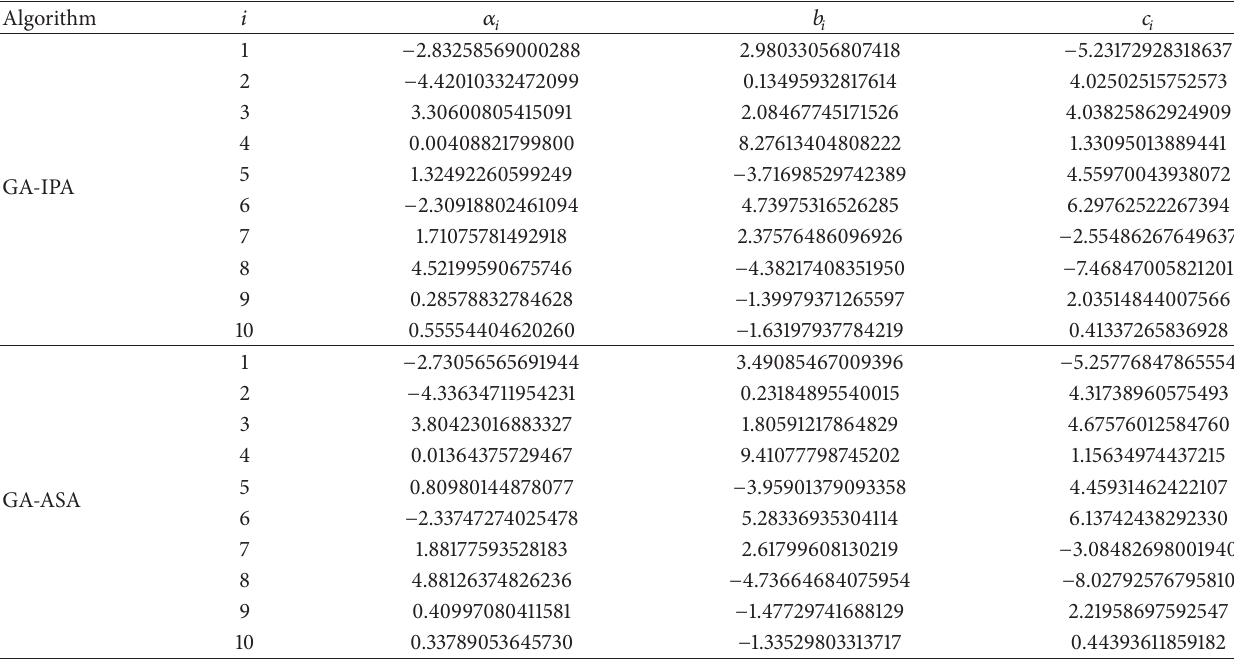
Table 10: Optimal values of adjustable parameters acquired by the hybrid schemes GA-IPA and GA-ASA (for 𝑚 = 0.75